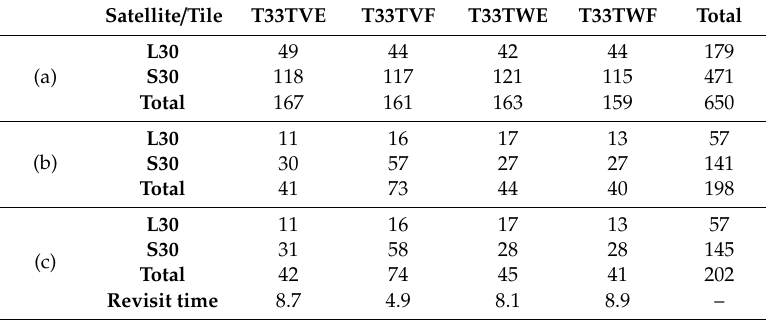
Table 1. Summary of the Harmonized Landsat Sentinel-2 (HLS) data selection process. (a) Number of initial images spanning year 2018. (b) Number of images after removing data covered by clouds or marginally overlapping ( < 20%) with the area of interest. (c) Number of final images used in the analysis in addition with the revisit time (in days) for each